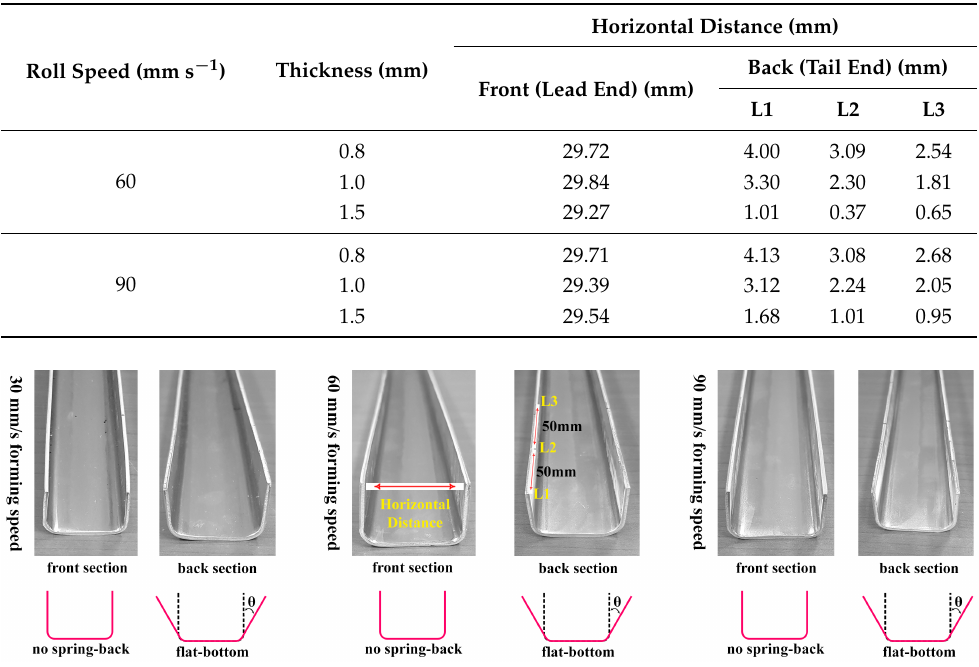
Table 3. Estimated spring-back values of tested cases from the experimental measurements.